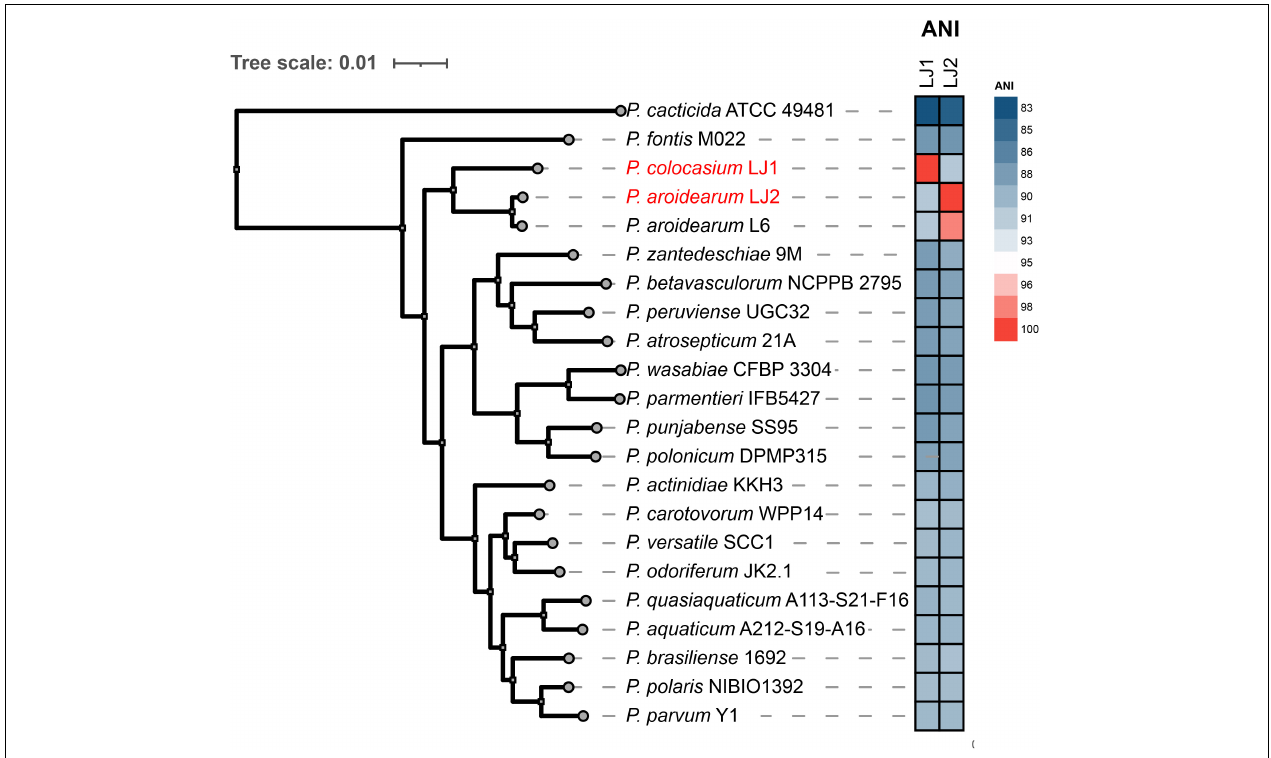
FIGURE 3 | Phylogenetic analysis of Pectobacterium colocasium sp. nov. LJ1, Pectobacterium aroidearum LJ2, and representative strains of the 20 known Pectobacterium species. The phylogeny on the left is a maximum-likelihood tree inferred using IQ-TREE based on a concatenation-based analysis of 1,621 single-copy genes identified in the Pectobacterium pan-genome analysis. All internal branches in the tree received 100% bootstrap support. A heatmap of the ANI values between LJ1/LJ2 and the 20 representative Pectobacterium strains is shown in the